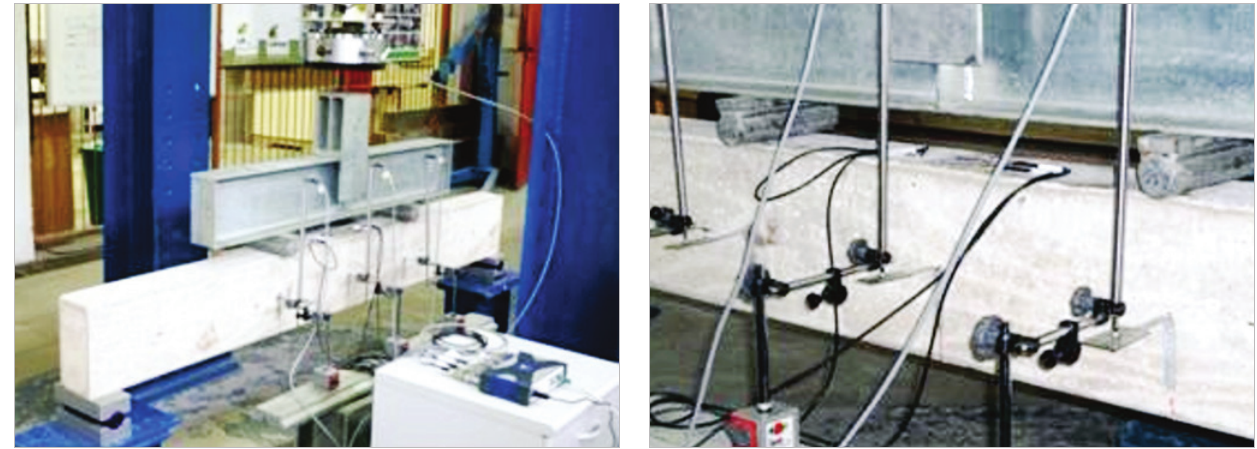
(a) Setup experimental of Geopolymer concrete beam; (b) Detail of LVDTs position and bonding of strain gauges in Geopolymer concrete beam